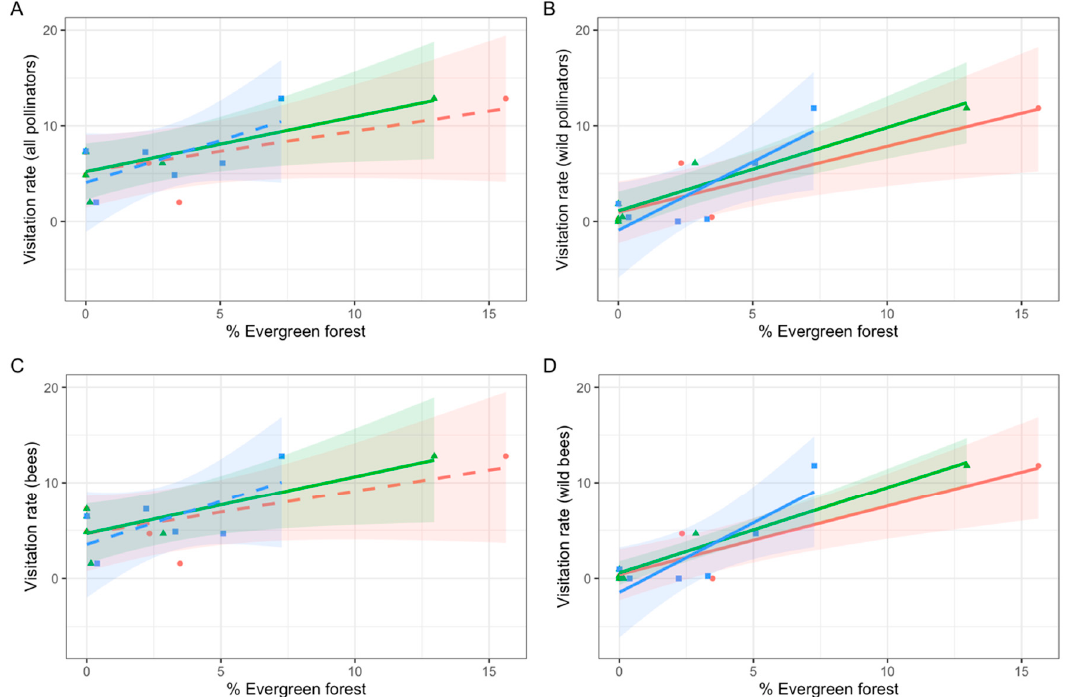
Figure 3. Visitation rate (visits/flower/15 min) in relation to the percentage of evergreen forest within a 1, 5 and 10 km radius from each study site: red circle = 1 km, green triangle = 5 km and blue square = 10 km and for four measures of visitation rate: ( A ) Visitation rate of all pollinators, ( B ) Visitation rate of wild pollinators, ( C ) Visitation rate of bees and ( D ) Visitation rate of wild bees. All regressions are printed with 95% corresponding confidence intervals. Solid lines indicate significant associations ( p < 0.05), whereas dashed lines indicated non-significant relationships ( p > 0.05). For statistics, see Table 2.